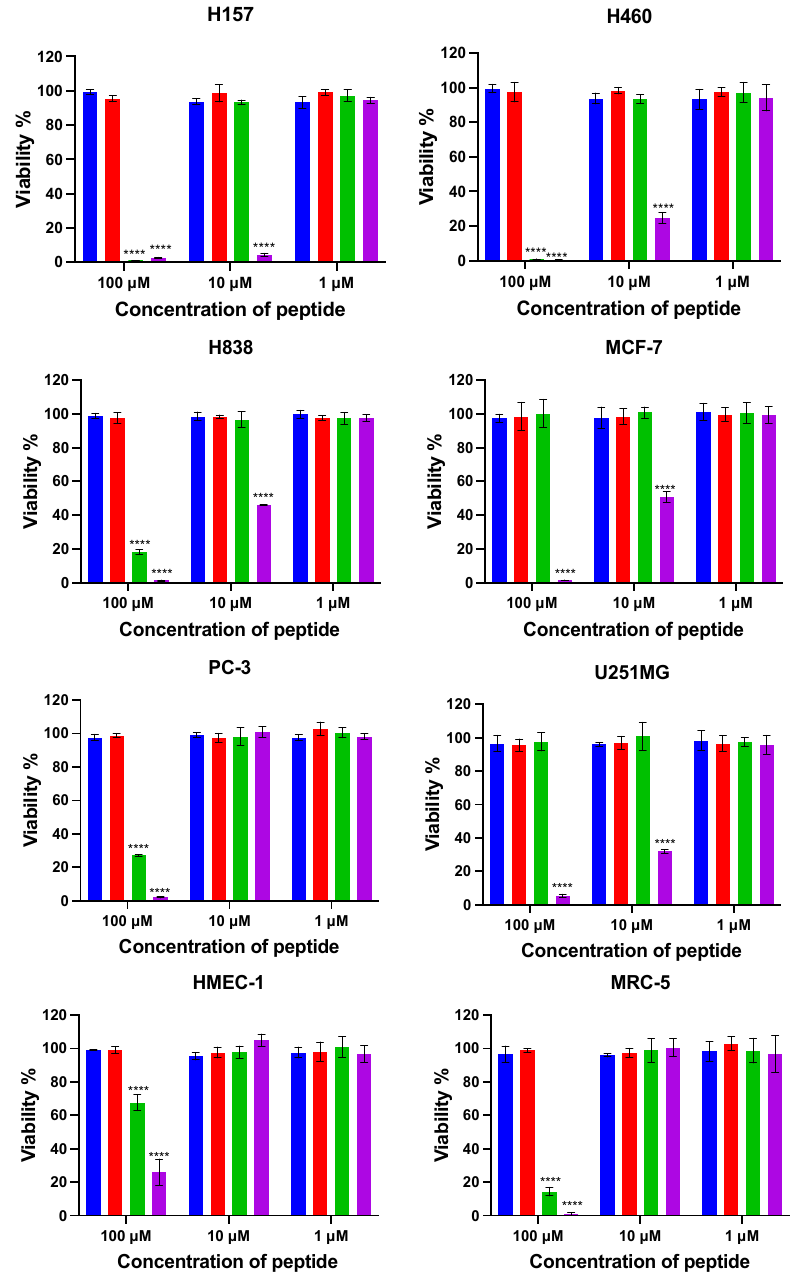
Figure 7. The cell viabilities were obtained after kunitzin-OV 2 (blue), F9-KOV 2 (red), TAT-KOV 2 (green), and TAT-F9-KOV 2 (purple) incubations with human lung cancer (H460, H157, H838), human breast cancer (MCF-7), human prostate cancer (PC-3), human glioblastoma (U251MG), human microvascular endothelial (HMEC-1), and human lung fibroblast (MRC-5) cell lines. The tested cells were treated with different peptides for 24 h. Cells of positive and negative groups were treated with 0.1% Triton X-100 and serum free medium, respectively. All sets of experimental data represent the means ± SEMs of nine replications in three experiments and the significant differences were calculated by comparing various treatments with the negative control (**** p < 0.0001).